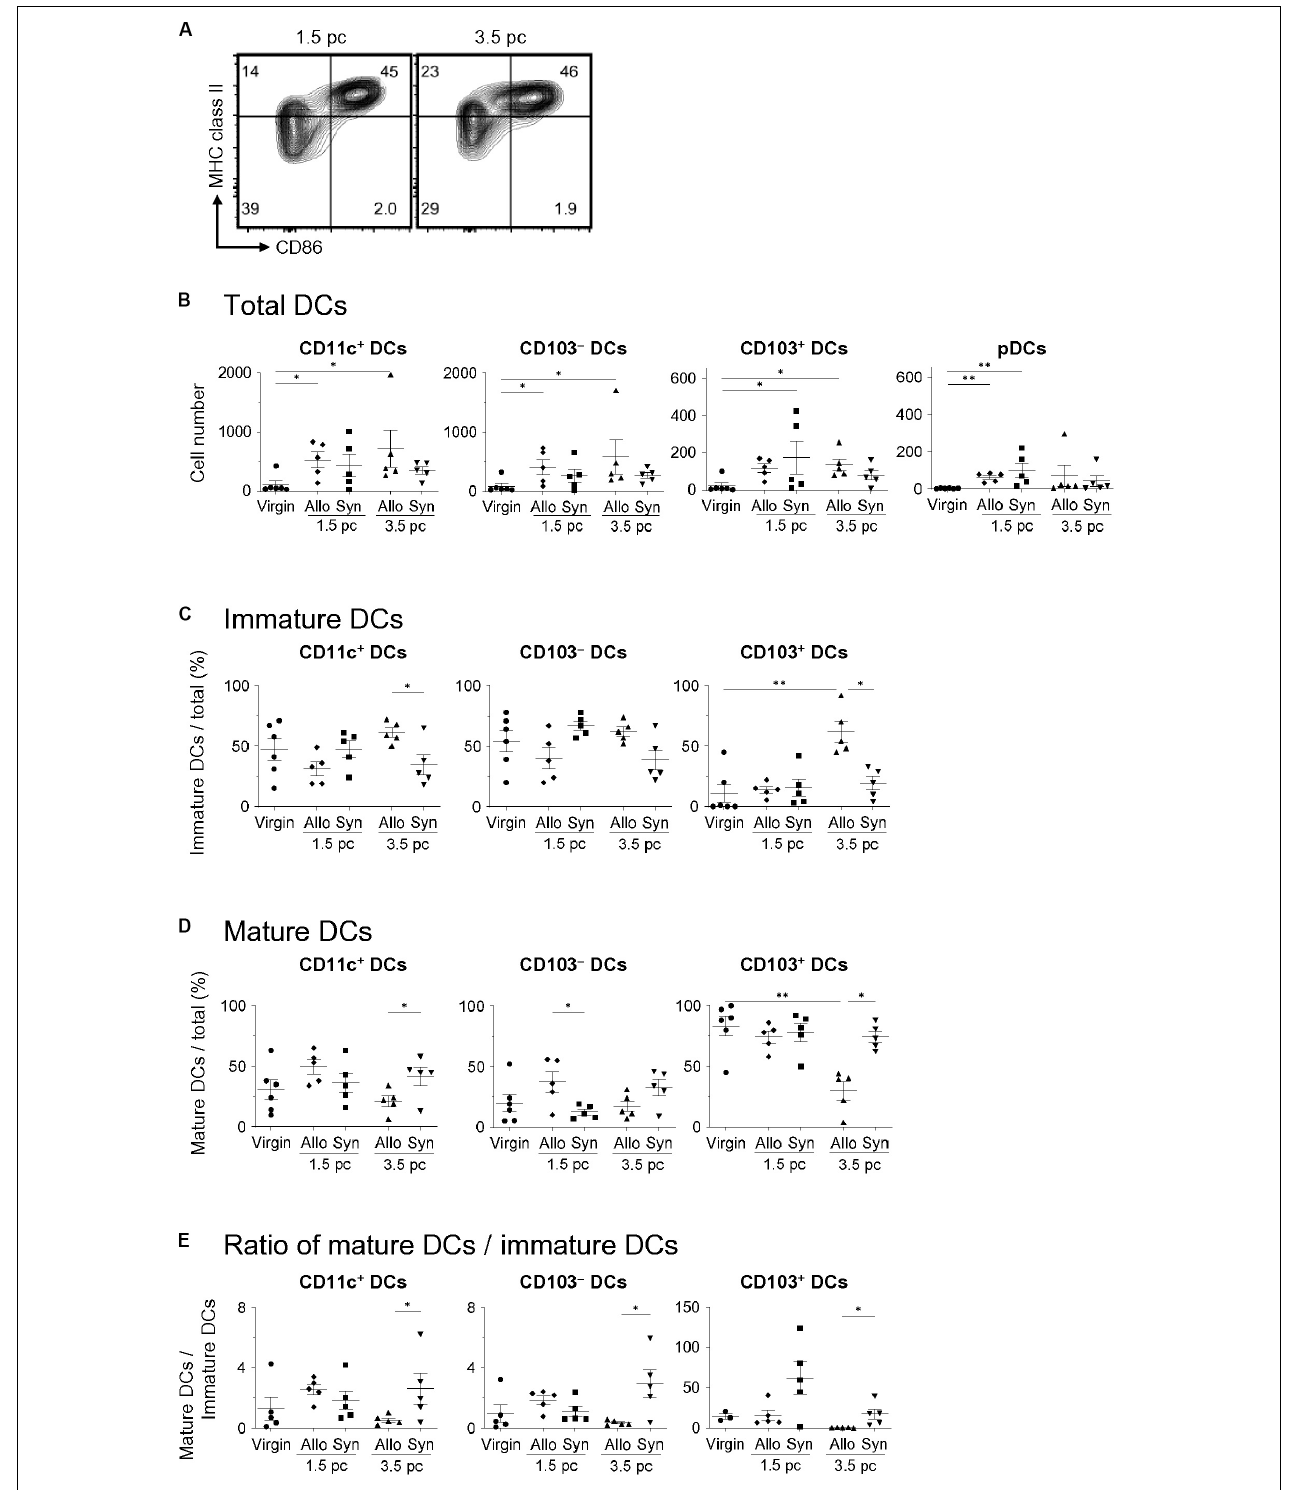
FIGURE 3 | Comparison of uDC phenotype between allogeneic- and syngeneic mating. (A) Flow cytometry contour plots show immature DCs and mature DCs in syngeneic mating on days 1.5 and 3.5 pc. (B,C) Graphs show total DC number (B) , proportion of immature DCs (C) and mature DCs (D) out of the total DCs, and the ratio of mature DCs/immature DCs within each DC subset (E) in virgin, allogeneic-, and syngeneic mating mice at each time point. A minimum of five samples from each time point were analyzed. Data represent mean ± SEM (B,C) and are representative of three independent experiments. Statistical comparisons were performed using Mann-Whitney U -test ( ∗∗ P < 0.01, ∗ P < 0.05).